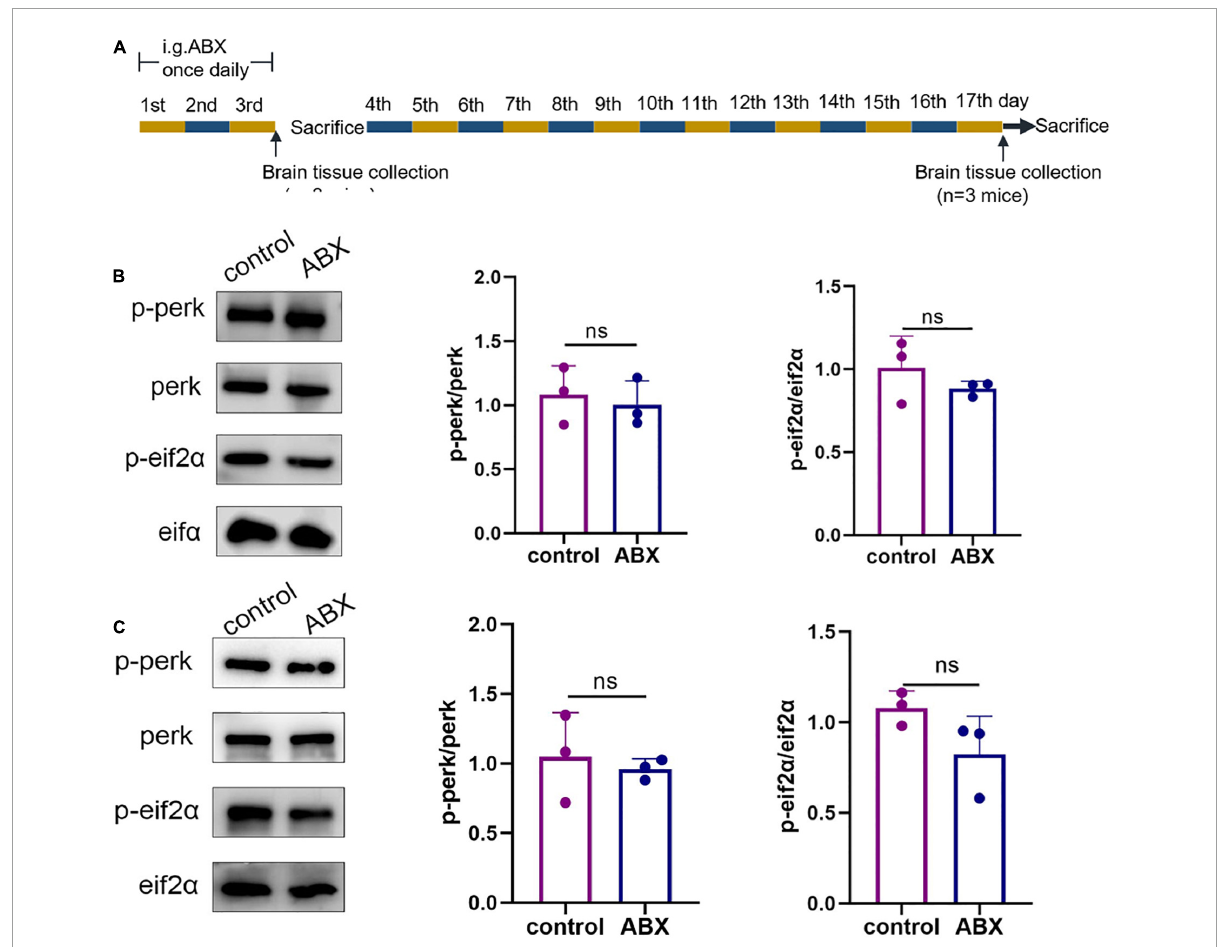
FIGURE1 Antibiotic cocktail administration did not affect endoplasmic reticulum (ER) stress in the cerebral cortex of wild-type (WT) mice. (A) Experimental design of antibiotic cocktail-treated WT mice (mice were administered an antibiotic cocktail by gavage). (B) Representative immunoblots showing p-perk and p-eif2a levels in the cerebral cortex on day 3 of the experiment; n = 3 for each group. (C) Representative immunoblots on day 17 of the experiment showed p-perk and p-eif2a levels in the cerebral cortex. Data were compared between the two groups using a two-tailed Student’s t